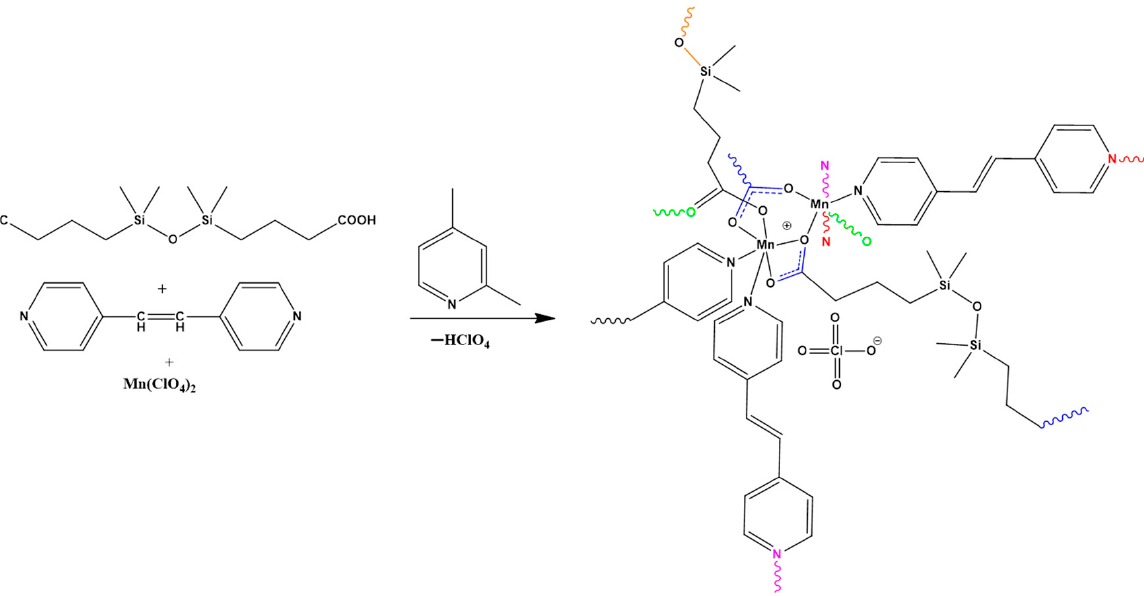
Scheme 1. The reaction leading to the 3D coordination polymer